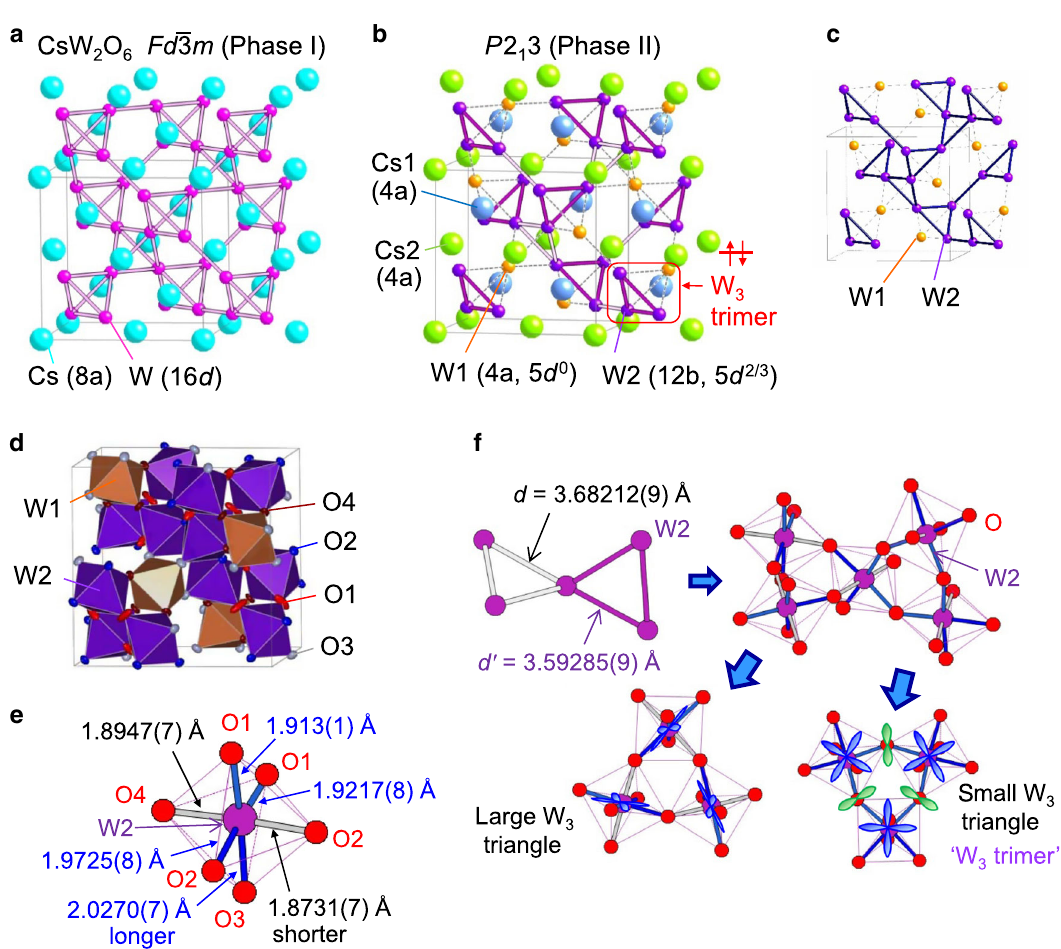
Fig. 2 Crystal structure of CsW 2 O 6 . a , b Crystal structures of the W and Cs sublattices of Phase I ( T > 215 K) and II (90 < T < 215 K). The purple triangles indicate the W 3 trimers. c Hyperkagome structure of W(2) atoms in Phase II. d Thermal ellipsoids of the oxygen atoms at 100 K (Phase II). e W – O bond lengths in a W(2)O 6 octahedron at 100 K (Phase II). f Schematic picture of the occupied 5 d orbitals in Phase II. The lower left and right panels indicate the W 3 O 15 units forming the larger and smaller triangles made of W atoms, respectively. The small triangle corresponds to the W 3 trimer. In the right panel, the 2 p orbitals of the bridging oxygen atoms are also shown.